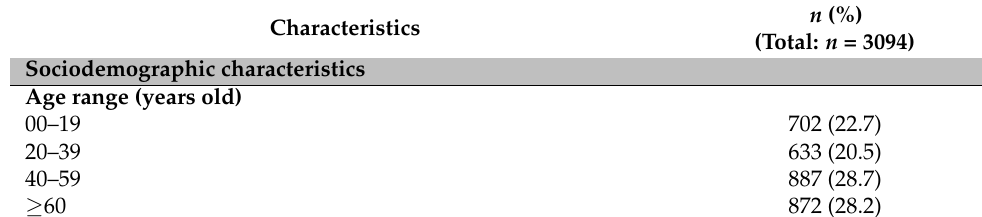
Table 1. Sociodemographic, clinical and treatment characteristics of patients with BL/L.